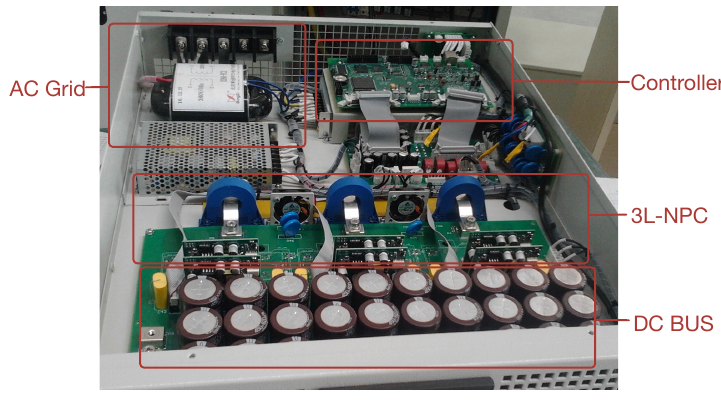
Figure 13. Hardware setup.